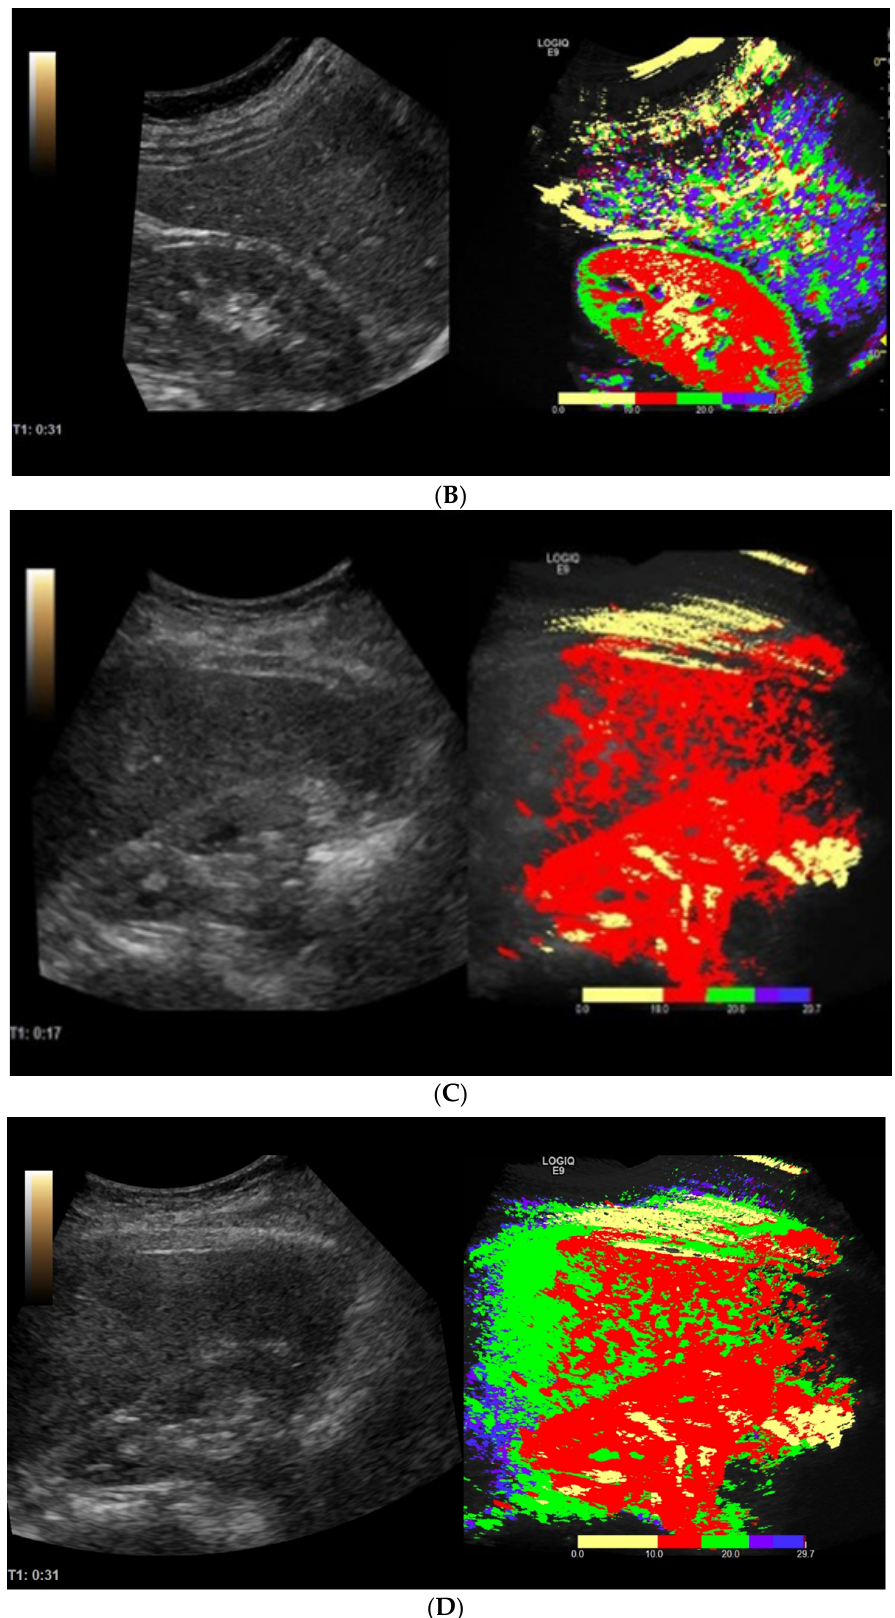
Figure 1. Healthy volunteer ( A ) in the first 10 s and ( B ) at the end of CEUS examination. Liver cirrhosis patient ( C ) in the first 10 s and ( D ) at the end of CEUS examination.